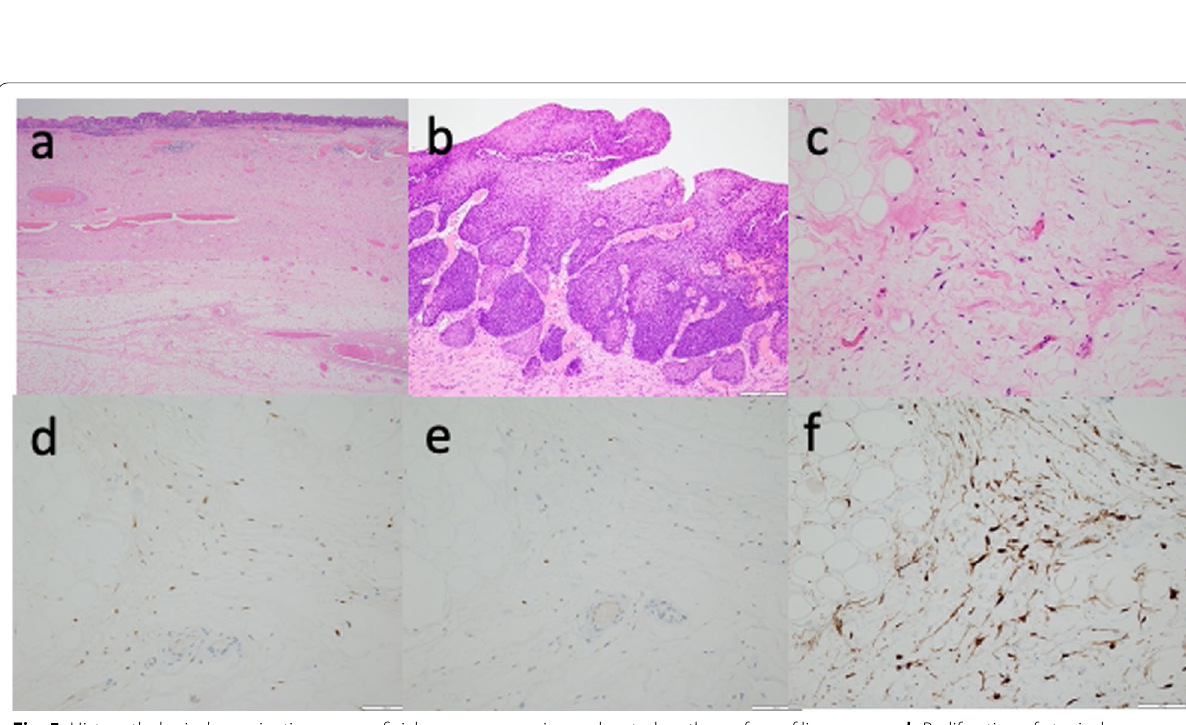
8.5 cm polypoid mass. b Superficial carcinoma located on the surface of the tumor ×